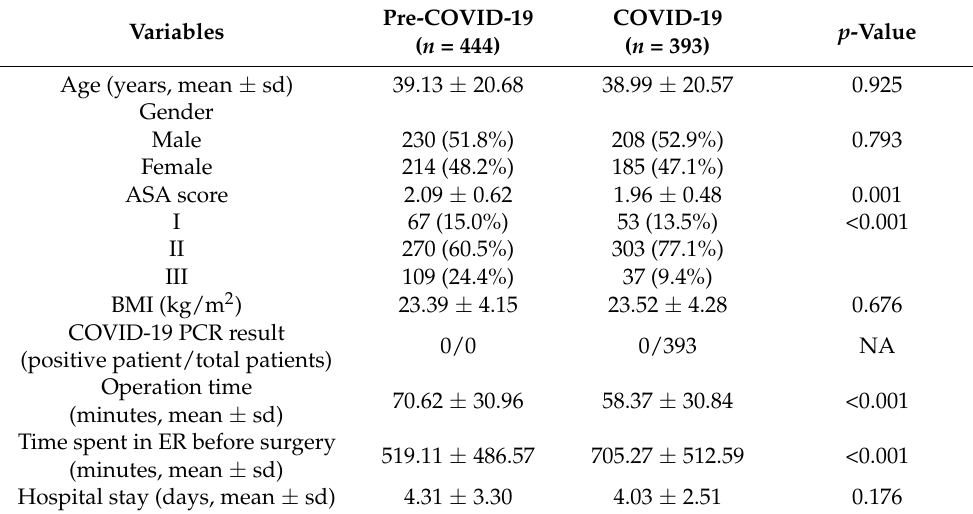
Table 1. Clinical characteristics of the appendicitis